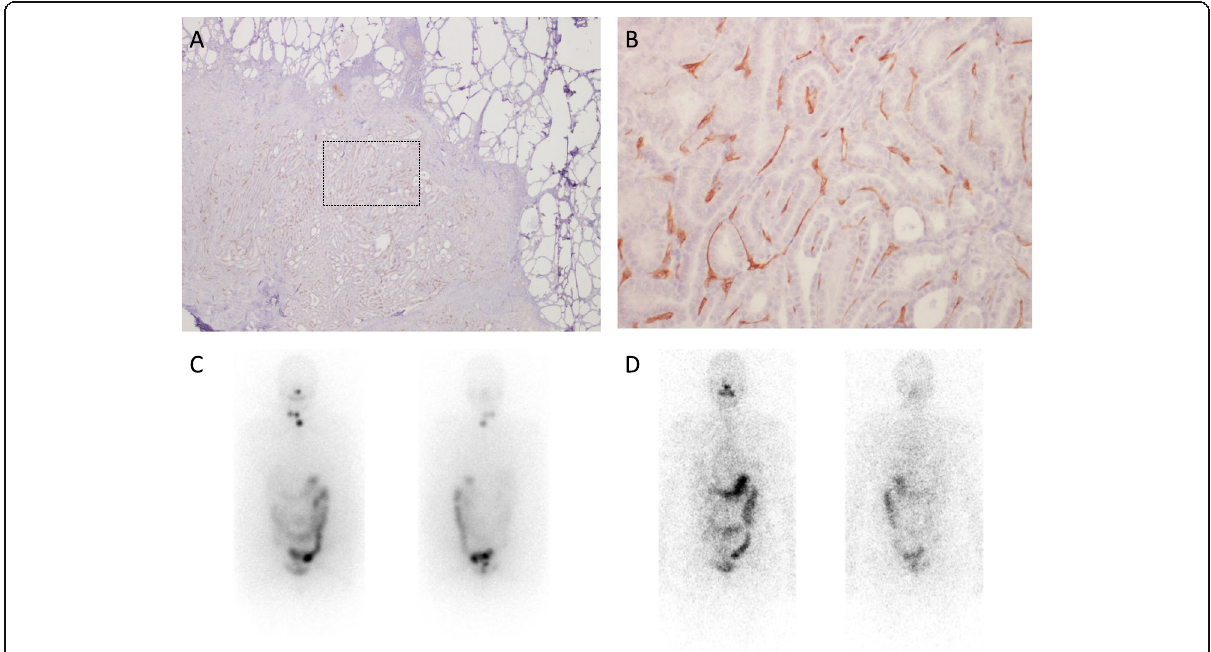
Fig. 3 Example of PSMA staining in a 45-year-old female diagnosed with a papillary thyroid cancer (presence of vascular invasion, free surgical margins, pT3mpN1bcM0 – stage I). Panoramic view ( a , × 2) shows diffuse PSMA staining which involves endothelial cells almost completely ( b , × 20) and was quantified as 90%. Planar images ( c ) obtained after radioiodine (RAI) treatment (2960 MBq) show uptake in the thyroid bed and in right cervical lymph nodes. At last follow-up (56 months after surgery), the patient was disease free (thyroglobulin 0.2 ng/mL), as also confirmed by diagnostic planar images ( d ) obtained after RAI administration (185